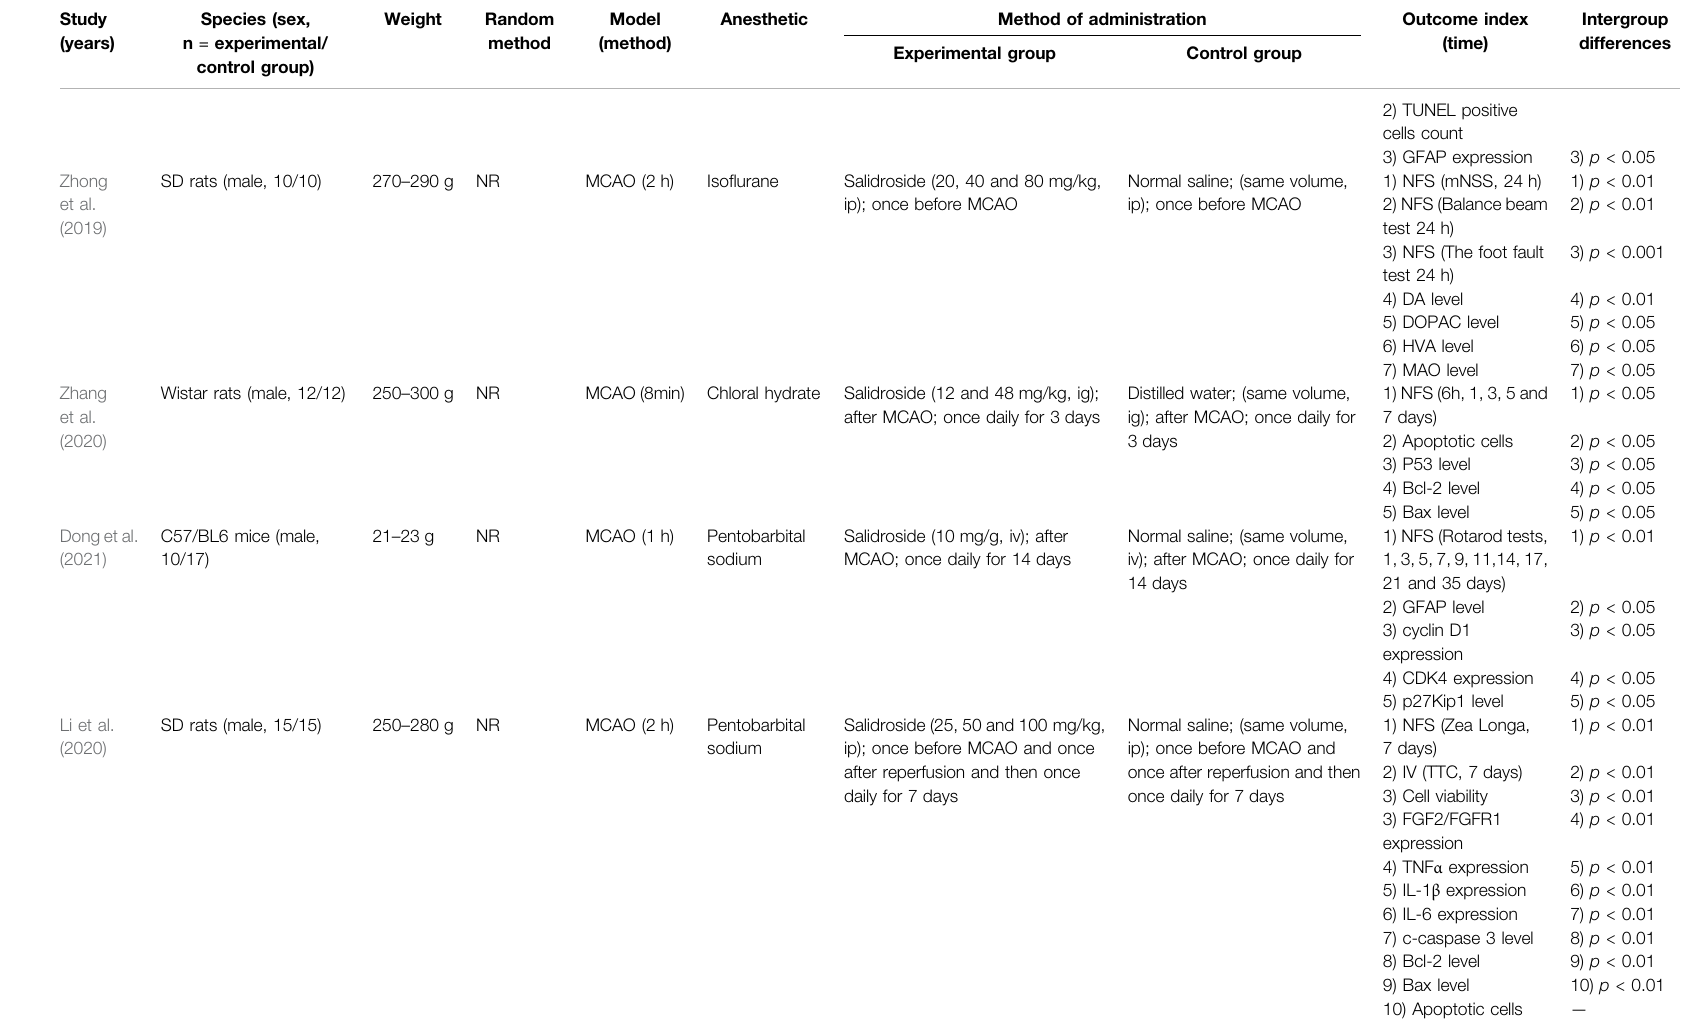
SD rats: Sprague-Dawley rats. MCAO: middle cerebral artery occlusion. SOD: superoxide dismute. HIF: hypoxia-inducible factor. NFS: neural functional de fi cit score. IV: infarct volume. ROS: reactive oxygen species. MAO: monoamine oxidase.HVA:homovanillicacid.DOPAC:dihydroxyphenylaceticacid.DA:dopamine.GFAP:glial fi brillaryacidicprotein.FGF2:Fibroblastgrowthfactor-2.FGFR1:Fibroblastgrowthfactorreceptor1.CDK4:Cyclin-dependentkinase4.PBS: phosphate-buffered